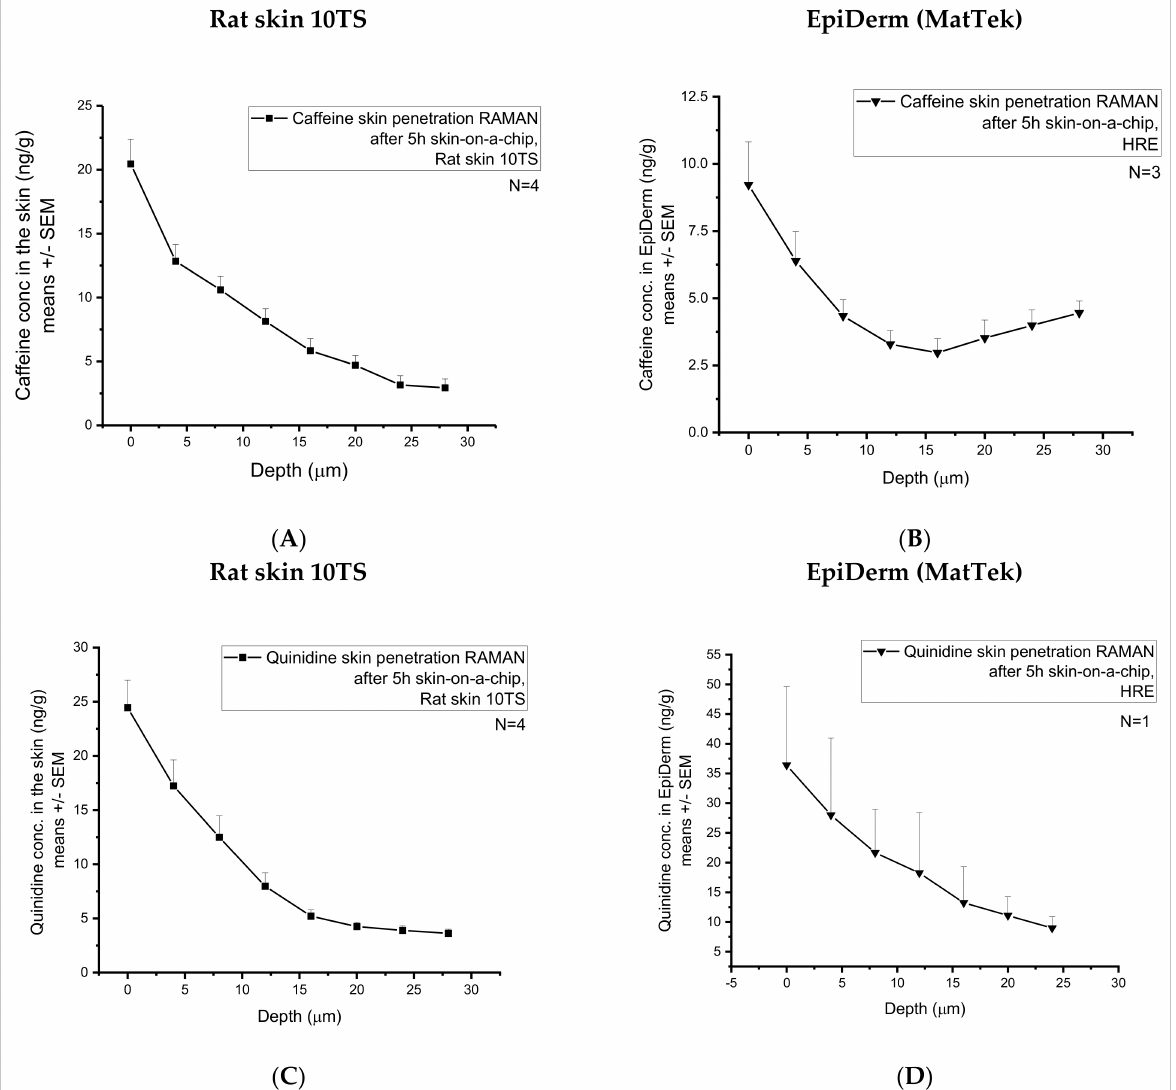
Figure 7. Accumulation of the two model drugs (caffeine and quinidine) in the skins and skin substi- tutes determined by Confocal Raman Spectroscopy. Caffeine penetration in mechanically pretreated rat skins ( A ) and in EpiDerm HRE tissues (MatTek) ( B ). Quinidine penetration in mechanically pretreated rat skins ( C ) and in EpiDerm HRE tissues (MatTek) ( D ). Four rat skins and 1-3 EpiDerm human-reconstructed epidermis were studied. N = 8–10 different z-profiling positions were applied for each individual